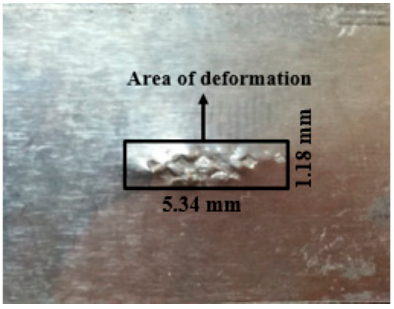
Figure 8. Area of deformation.